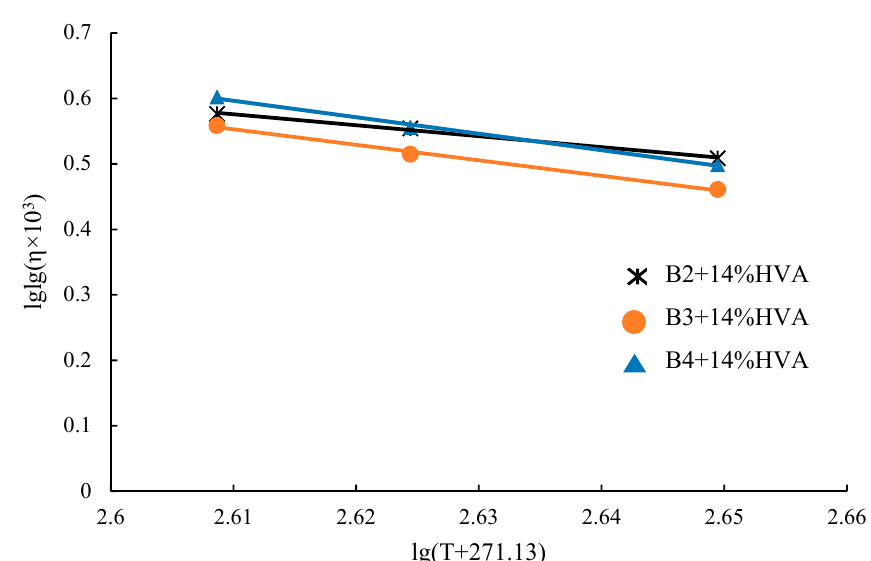
Figure 10. Viscosity-temperature curve of three asphalt with 14% HVA on double logarithmic coordinates.